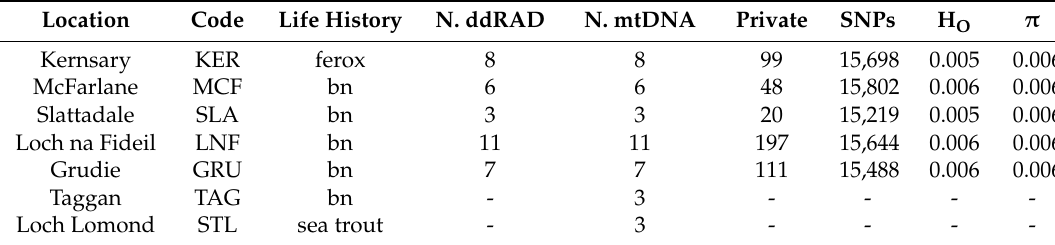
Table legend: bn: benthivorous brown trout; Number of individuals genotyped using ddRADseq (N.ddRAD) and number of individuals used for mitochondrial ND1 gene amplification (N.mtDNA); Private: Number of private sites in global ddRADseq dataset; SNPs: Total number of SNPs in global ddRADseq dataset; H O : Observed heterozygosity. Genetic diversity measures were calculated based on all sites (variant and